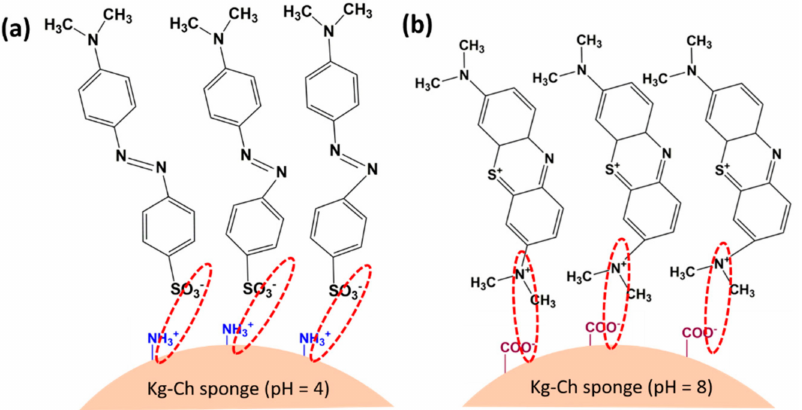
Figure 12. Schematic representation showing functional group interactions of ( a ) MO with Kg-Ch sponge at pH = 4.0 and ( b ) MB with Kg-Ch sponge at pH = 8.0. The ATR-FTIR spectra of the Kg-Ch sponge (before and after MB and MO